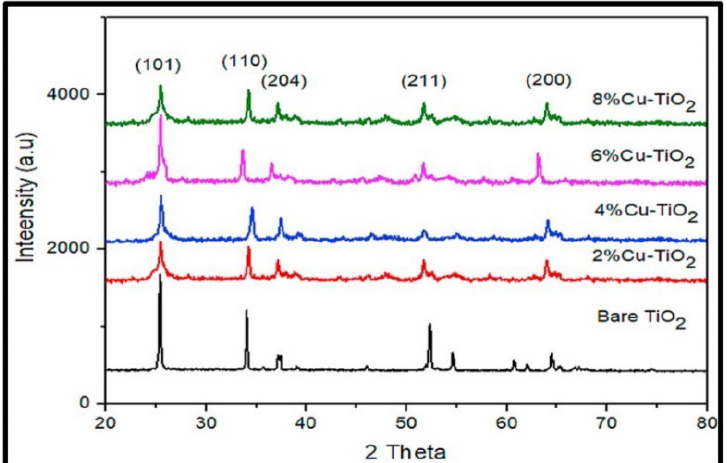
Figure 18. Comparative X-ray diffraction analysis of pure TiO 2 and Cu-Doped TiO 2 NPs at varying concentrations. Reprinted from [66].